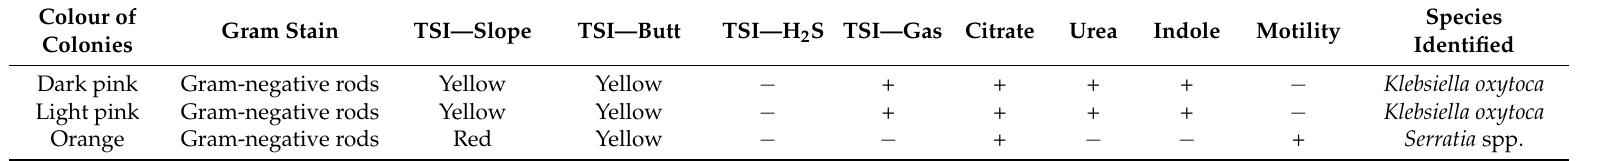
Table 1. Results of differential tests used for identification of bacterial species present on M. oleifera leaves. Colour of